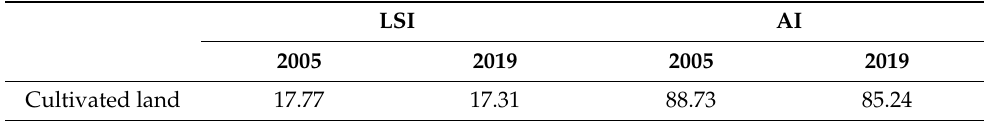
Table 4. Class level index in 2005 and